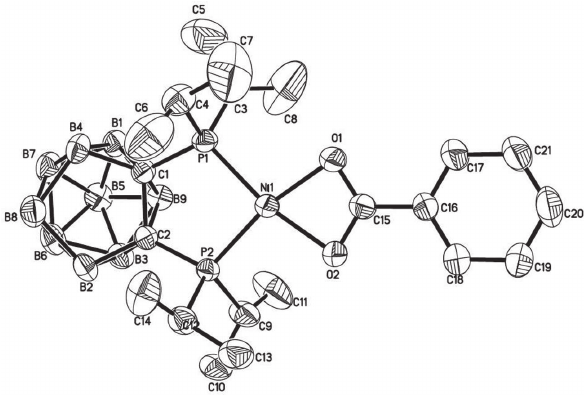
Table 1: Data collection and